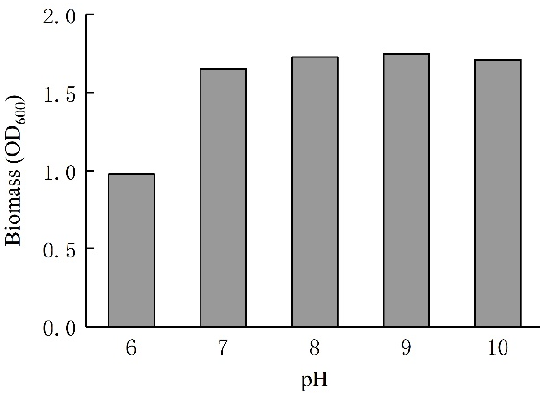
Figure 4. OD600 value of Bacillus pasteurii at different pH.